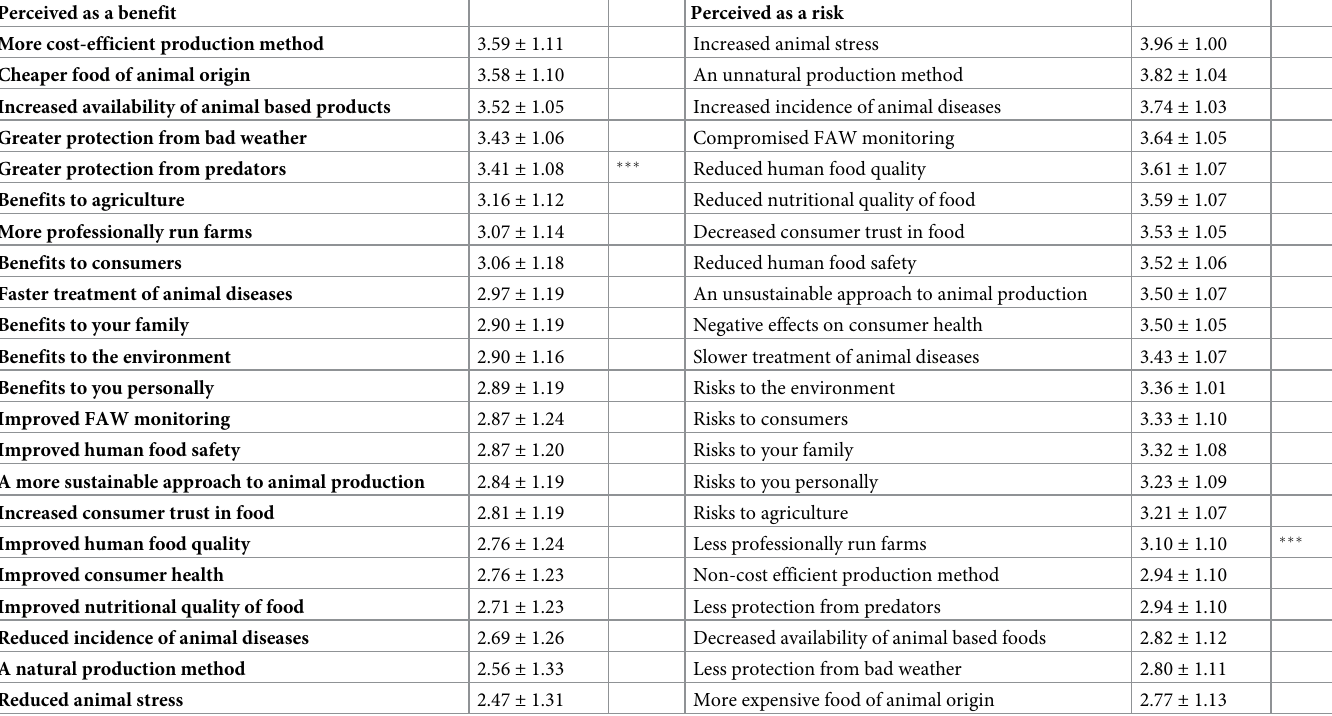
Table 3. Risk and benefit perceptions of respondents in the five study countries regarding intensive layer hen production systems (mean response on a linear scale 1 (strongly disagree) to 5 (strongly agree) ± SD; n =